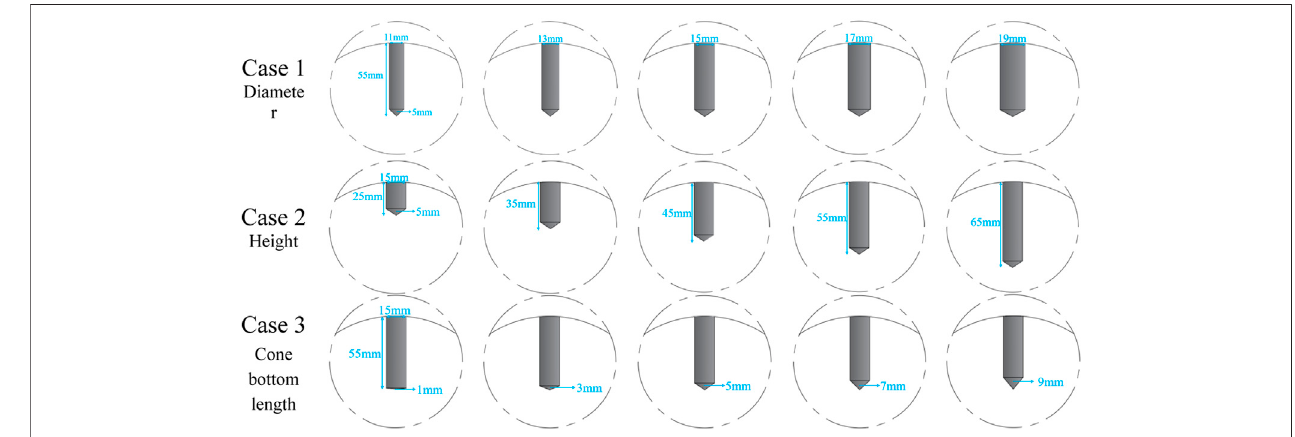
FIGURE 2 | Various geometrical factors of the hole.